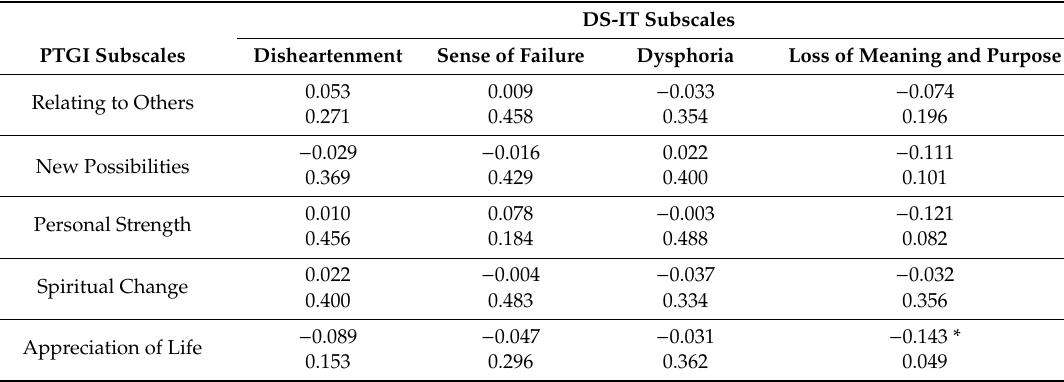
Table 6. Correlation between DS-IT subscales and PTGI